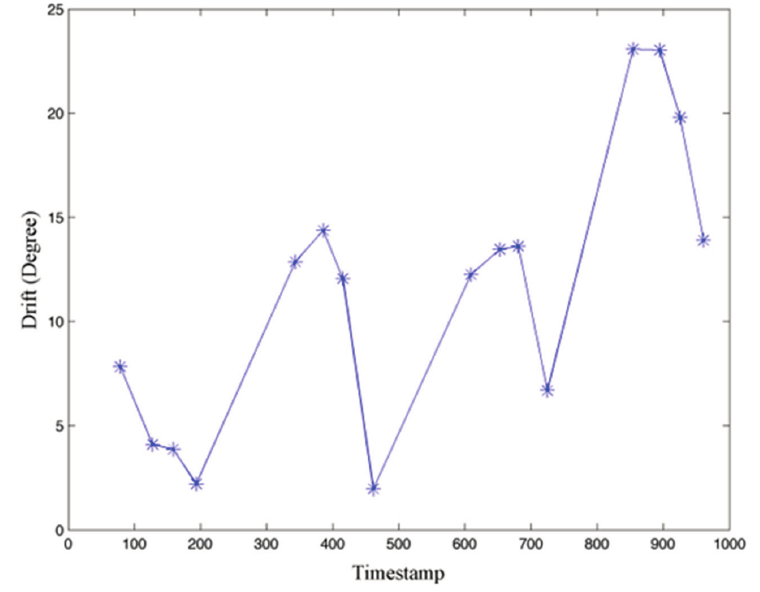
Figure 12. Gyroscope drift in yaw